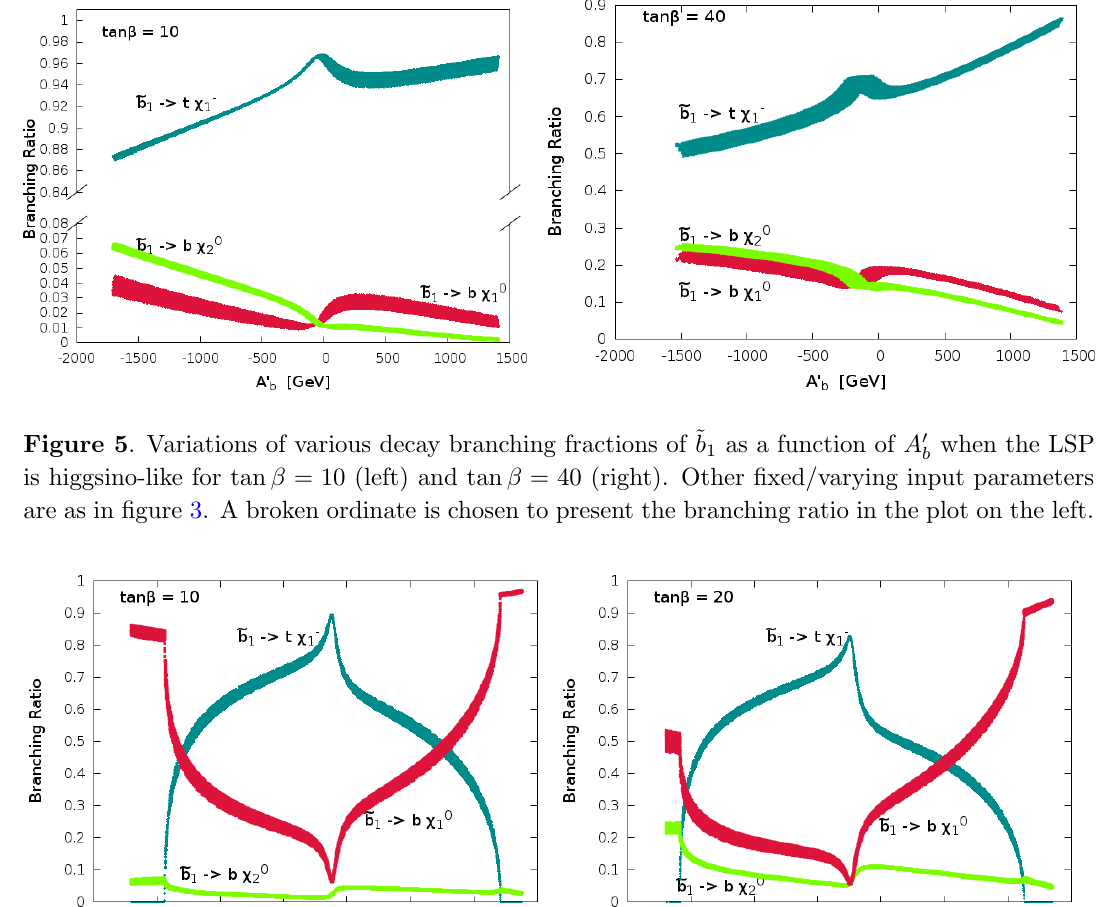
Figure 6 . Same as in (cid:12)gure 5 but for a bino-like LSP. Other (cid:12)xed/varying parameters are as in (cid:12)gure